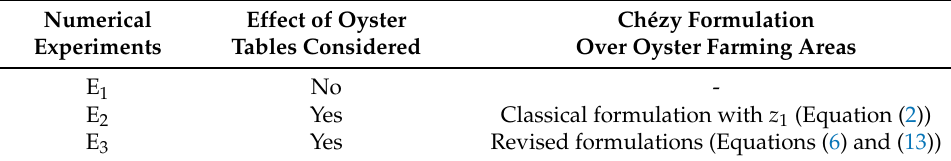
Table 2. Numerical experiments